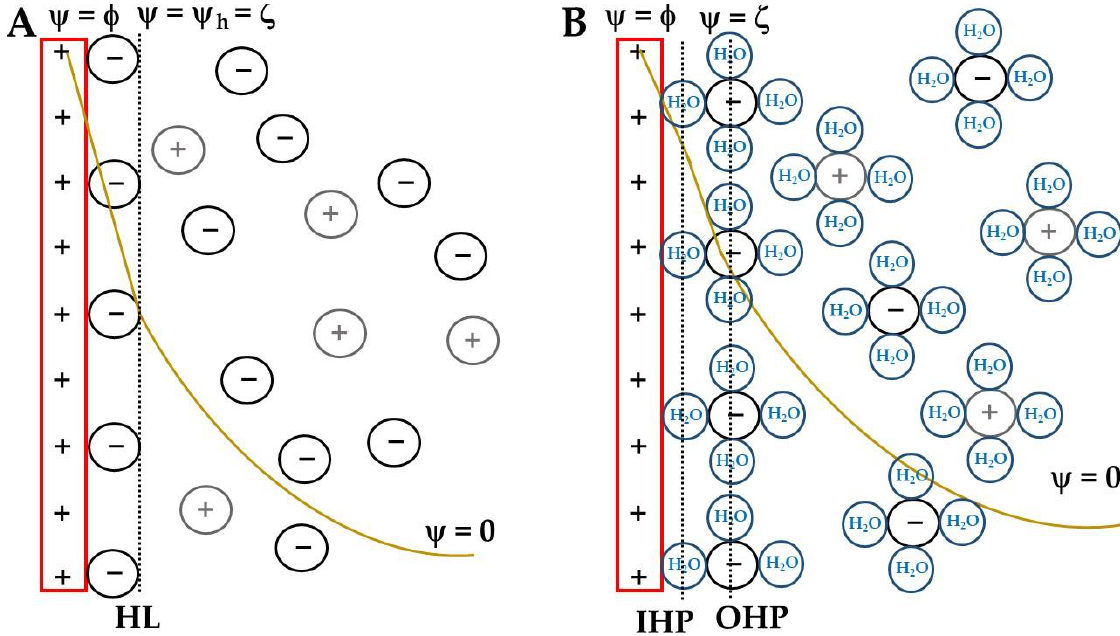
Figure 3. ( A ) Stern’s electric double layer model. Being the positively charged electrode in a red rectangle, the potential drop as a function of the distance from the electrode is a golden line. The initial anion layer is marked with a dotted black line, the Helmholtz layer. Anions are represented by black circumferences and cations as gray ones. ( B ) Grahame’s adaptation of Stern’s model is for the electric double layer. The solvent molecules were added (blue circumferences), and the HL was divided into two regions, the inner Helmholtz plane (IHP) and the outer one (OHP). The Helmholtz potential ( ψ h ), or ζ -potential, is also shown at the end of the HL in A and OHP in B.